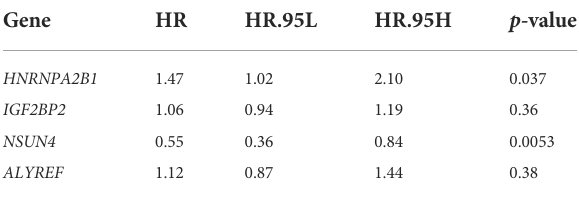
TABLE 2 Multivariate Cox regression